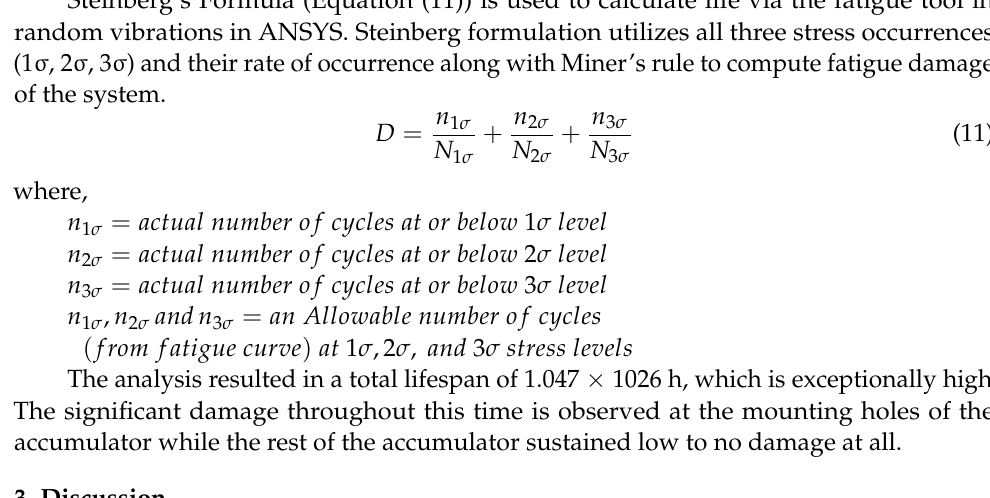
Figure 19. Directional deformation (mm) for 3 Sigma scale factor. The maximum deformation is 0.45 mm towards the top of the accumulator module.